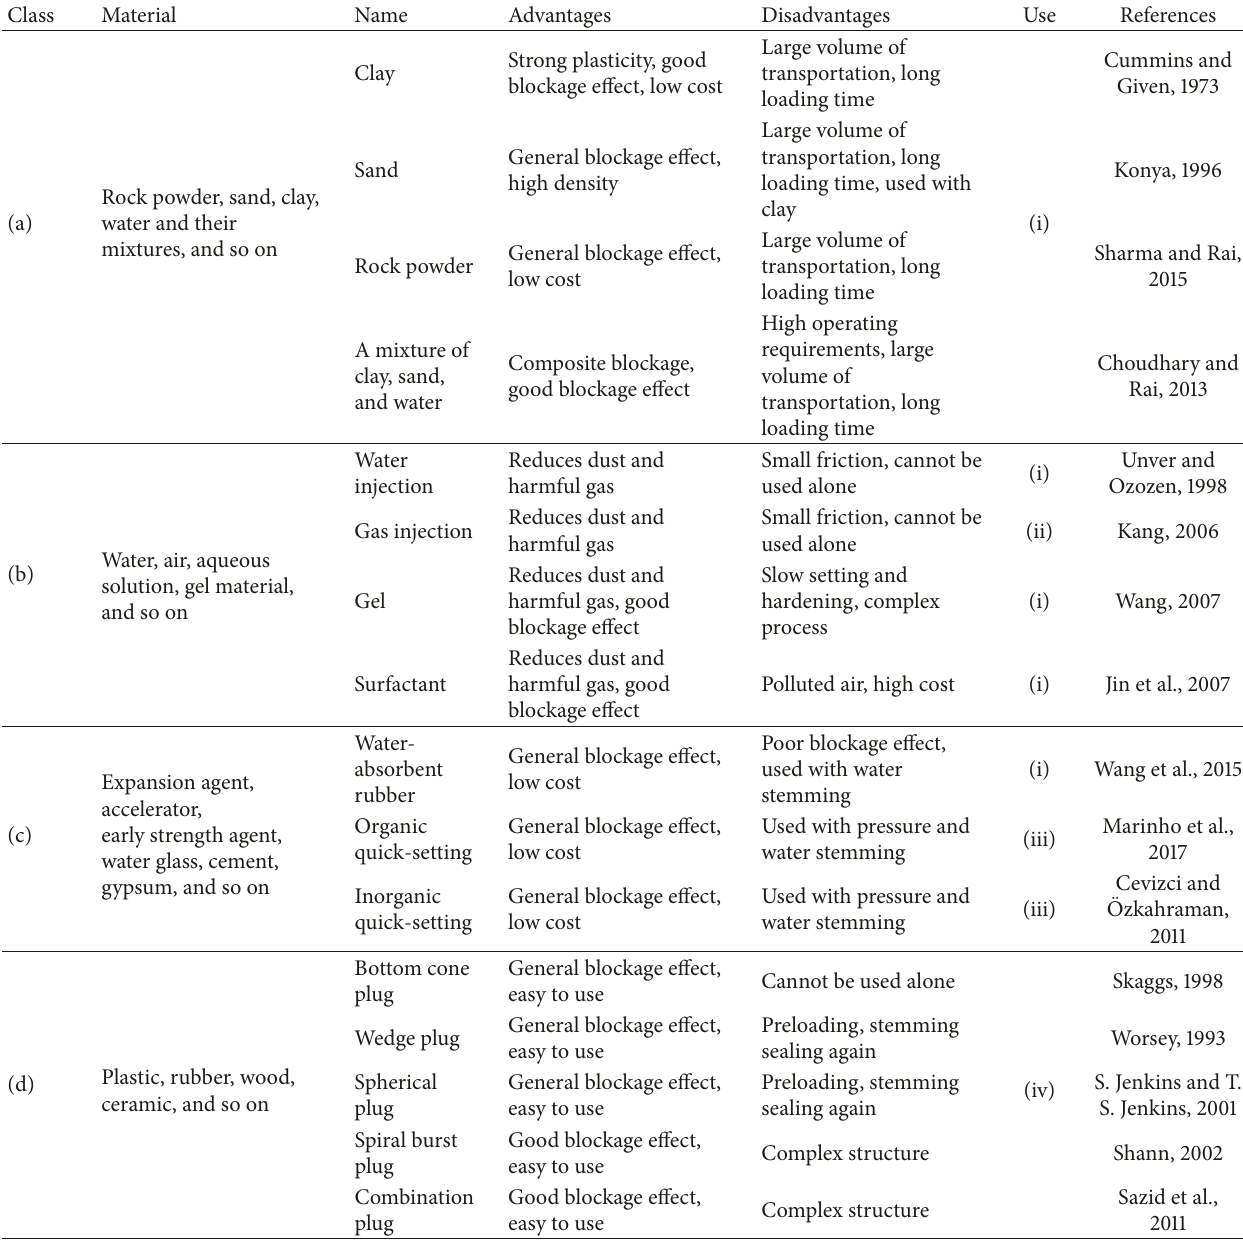
Table 1: Classification of hole